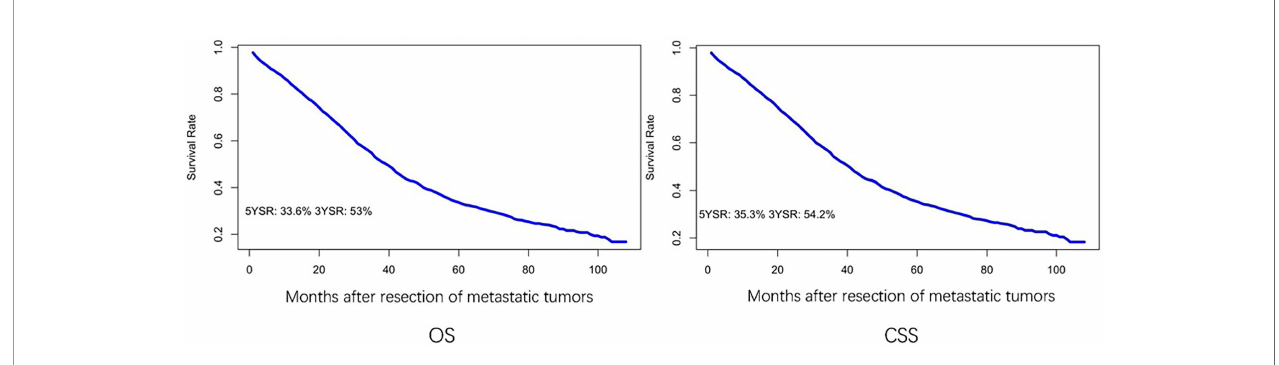
FIGURE 2 | Kaplan – Meier curve of OS and CSS after resection of LM and/or PM in CRC. YSR, year survival rate.